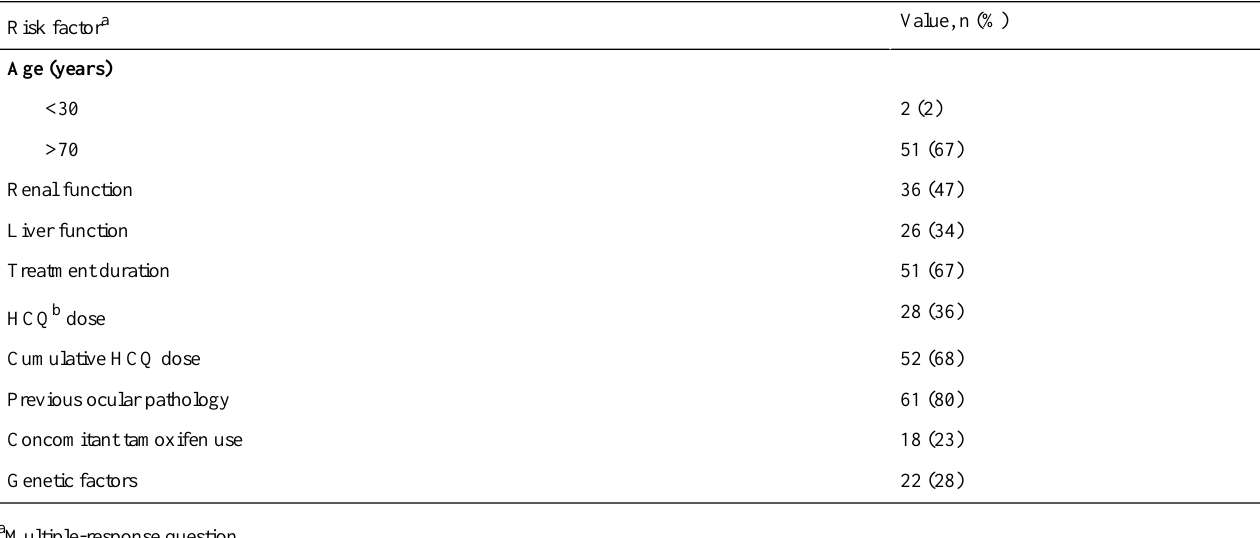
Table 5. Factors considered by dermatologists as risk factors for retinal toxicity.